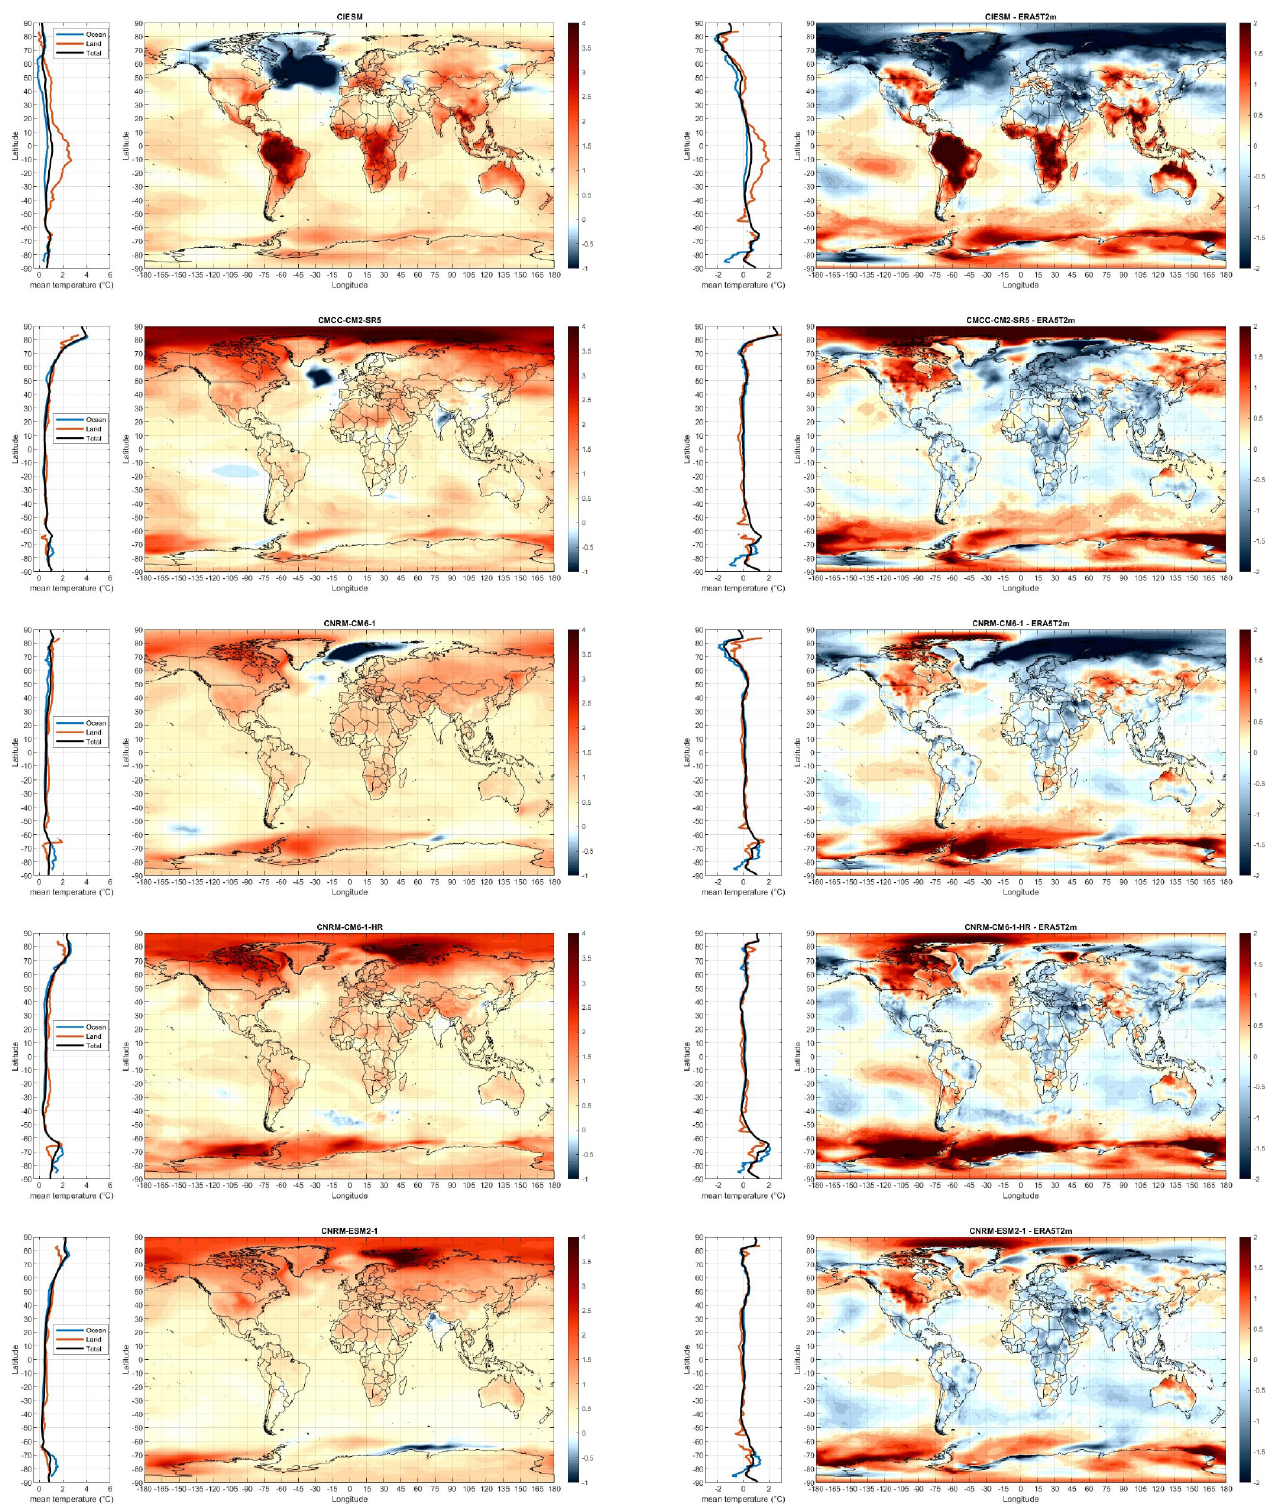
Figure A3. Warming patterns from 1980–1990 to 2011–2021 for the indicated CMIP6-tas GCM ( left ) and its comparison against the ERA5-T2m record ( right